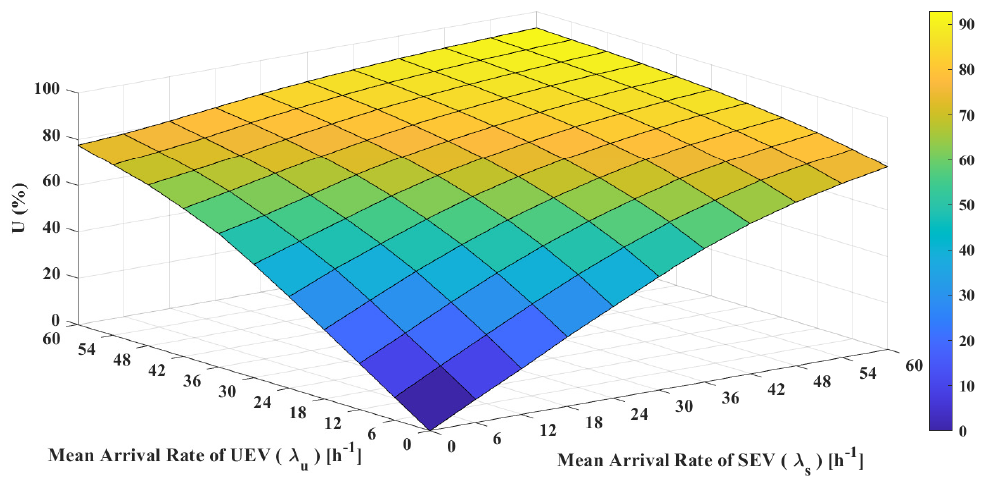
Figure 5. Charging resource utilization with λ s and λ u